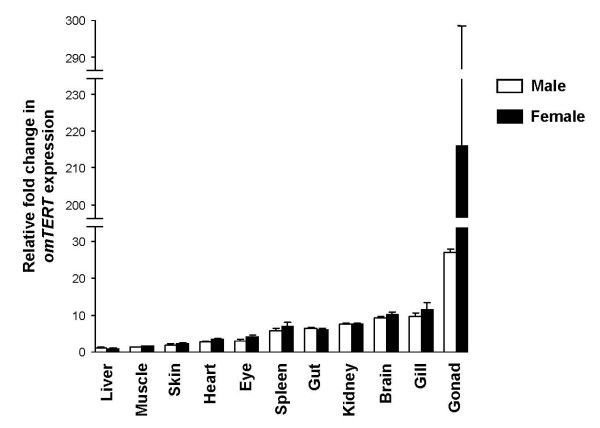
In vivo expression of omTERT mRNA. Expression of omTERT in various O. melastigma tissues of male (open bar) and female (solid bar) fish (n = 5) were quantified using real-time RT-PCR and normalized against 18S rRNA. Data are presented as mean relative fold changes ± SEM with respect to expression level in the liver of female fish (arbitrarily set to 1).